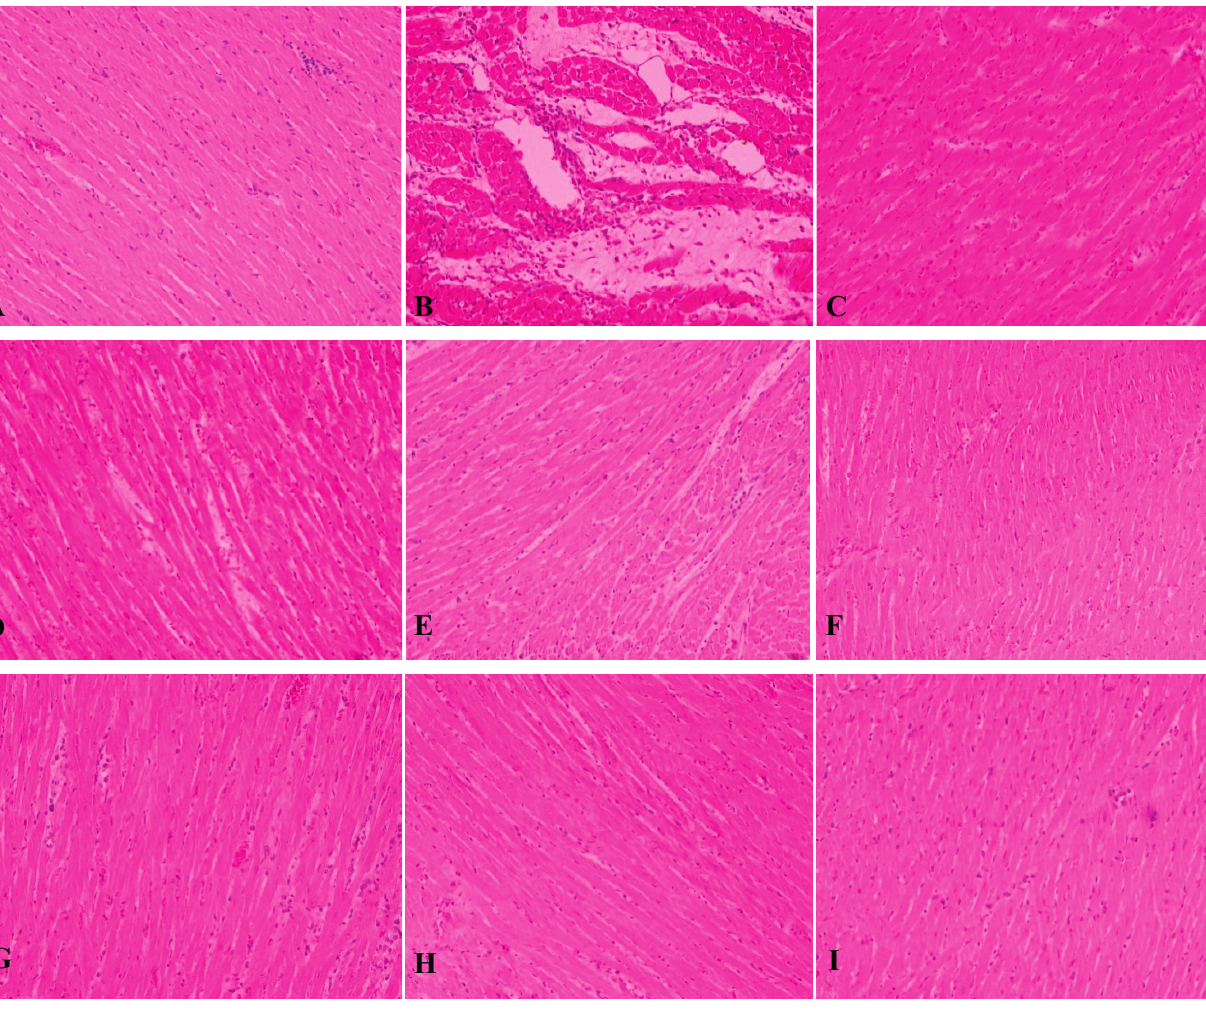
Figure 4. Effect of the aqueous (AqELP) and 80% ethanol (EtELP) extracts of Labisia pumila var. alata on histopathological changes, ( A ) control (normal), ( B ) ISO (negative control), ( C ) propranolol 10 mg/kg (positive control), ( D ): AqELP 100 mg/kg, ( E ) AqELP 200 mg/kg, ( F ) AqELP 400 mg/kg, ( G ): EtELP 100 mg/kg, ( H ): EtELP 200 mg/kg and ( I ): EtELP 400 mg/kg. Heart tissues (4 µm thickness) were stained with hematoxylin and eosin and visualized under light microscope at ×10